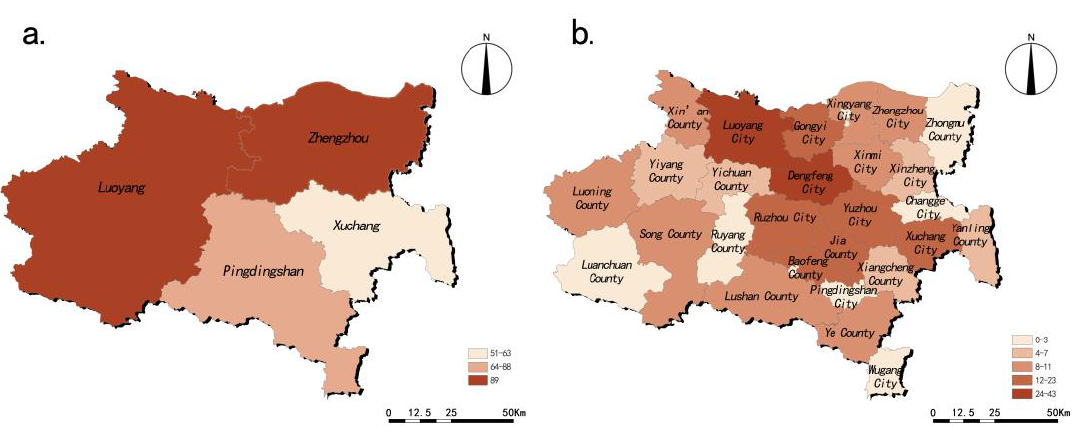
Figure 5. The quantity of historical buildings distributed in different administrative units in the Songshan region. ( a ) Macro-administrative units; ( b ) Micro-administration units.